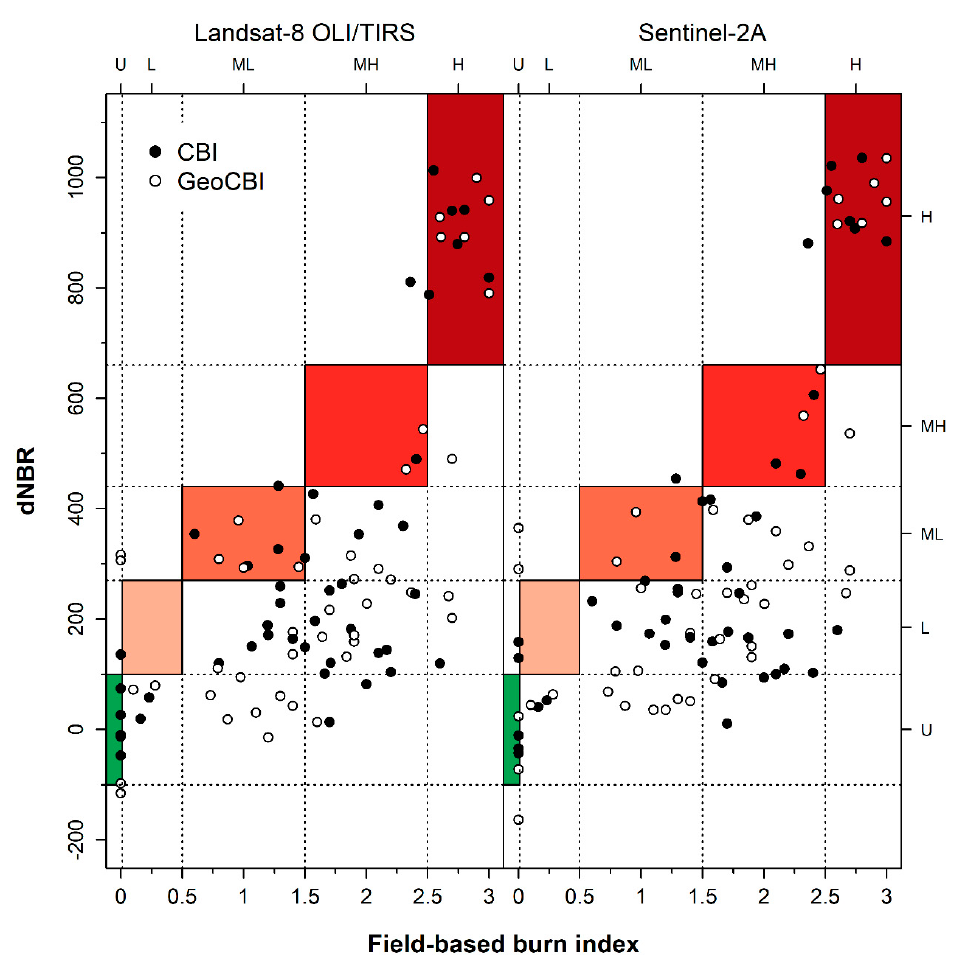
Figure 2. Relationship between satellite-derived (Landsat-8 OLI and Sentinel 2A MSI in the left and right panels, respectively), differentiated normalized burn ratio (dNBR) and field-based composite burn index (white circle—CBI; black circle—GeoCBI). Both left and bottom axis values are plotted on a continuous scale number. Colored square boxes represent burn severity class ranges corresponding to USDA and field-based burn index thresholds. On the top and right axes, the discretized burn severity classes are plotted, respectively, for the field-based burn index and satellite-based dNBR metric. Dotted lines indicate threshold values for each of the two burn index metrics. Burn severity class codes U, L, ML, MH, and H correspond respectively to Unburnt, Low, Moderate-low, Moderate-high, and High (see Table S1).